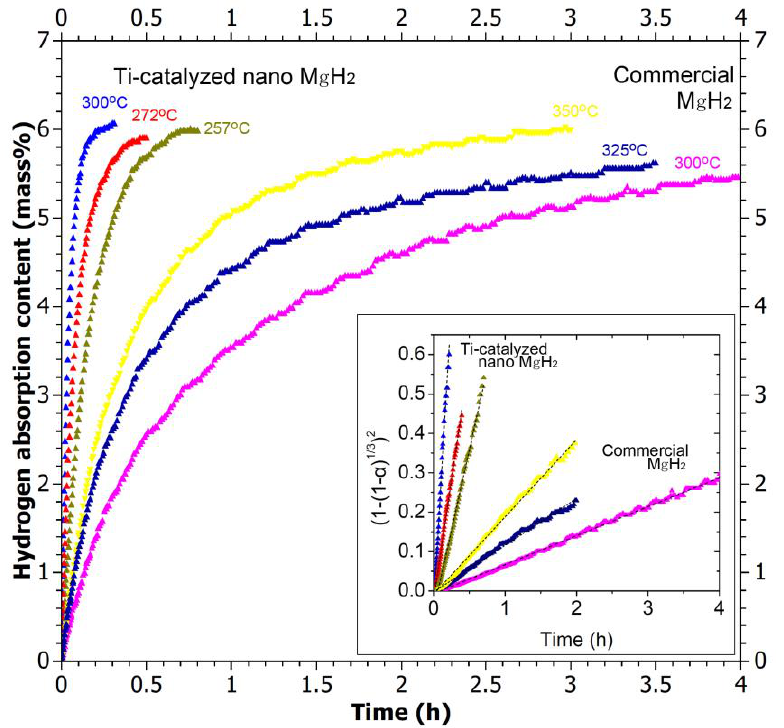
Figure 2. Hydrogen re-absorption curves of Ti-catalyzed MgH 2 nanocrystalline sample and commercial MgH 2 sample (Alfa Aesar) at different temperatures in 1 MPa hydrogen after complete desorption (inset: absorption curves simulated by Jander diffusion equation). Adapted with permission from [29], Copyright IOP, 2011.